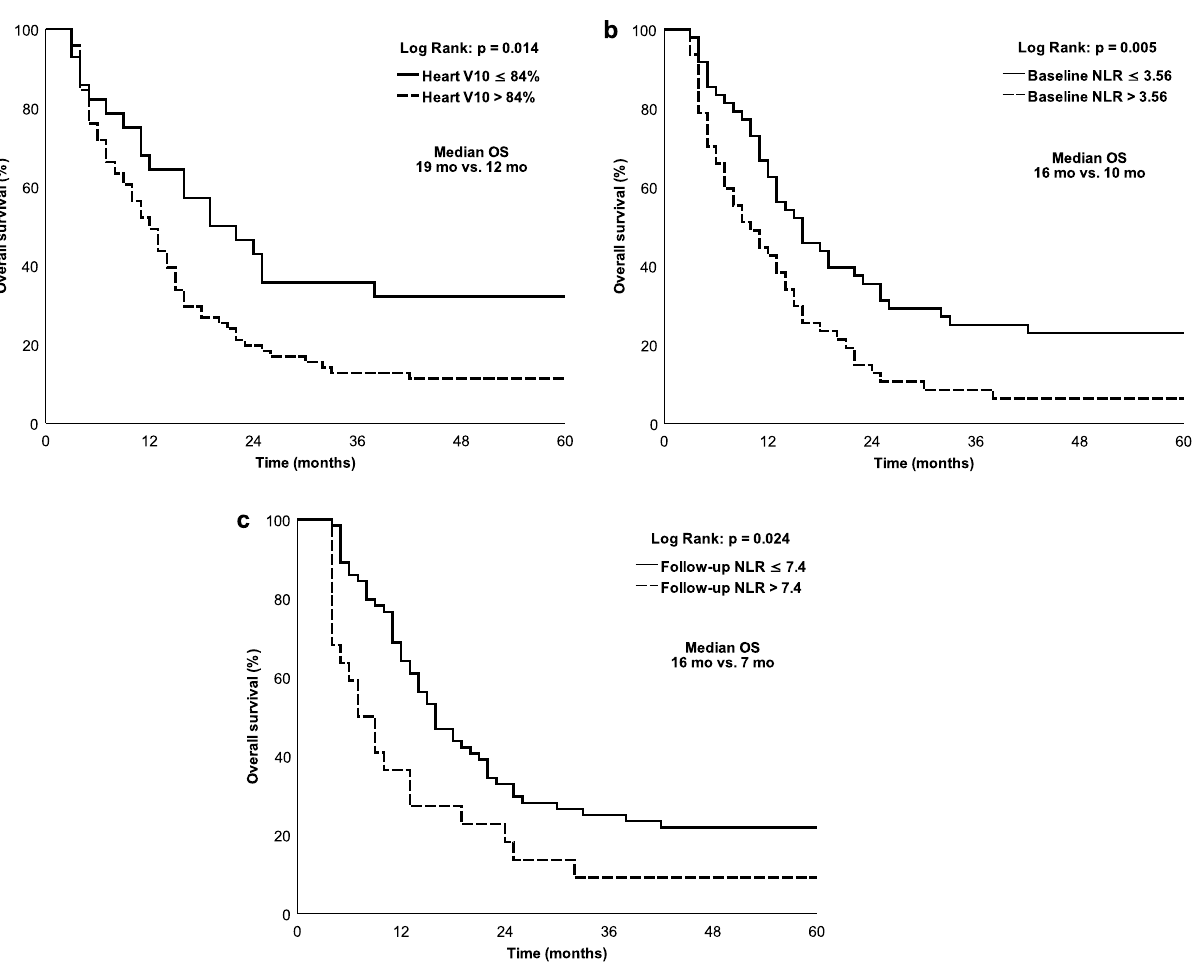
Figure 1. Kaplan–Meier’s curves for OS (overall survival), and patients are stratified by ( a ) heart V10 as > 84% (dotted line) or ≤ 84% (solid line); ( b ) baseline NLR as > 3.56 (dotted line) or ≤ 3.56 (solid line); ( c ) follow-up NLR as > 7.4 (dotted line) or ≤ 7.4 (solid